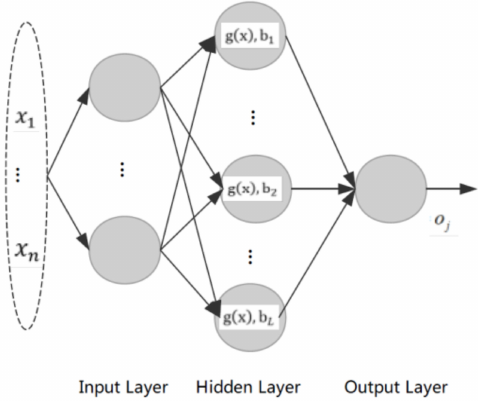
Figure 3. Structure of Extreme Learning Machine (ELM)